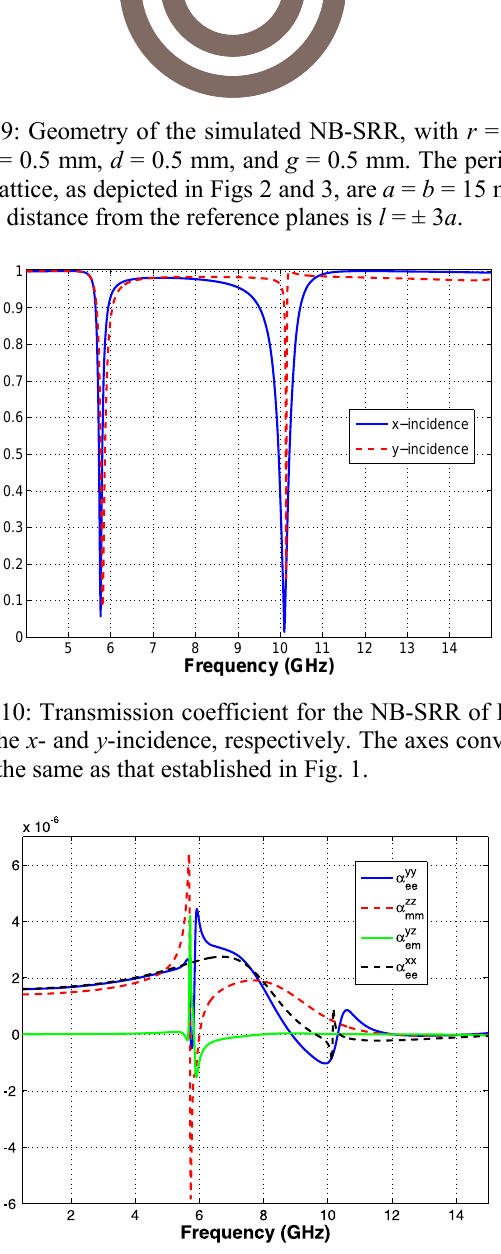
Figure 11: Real part of the polarizabilities of the NB-SRR, extracted via the proposed method.